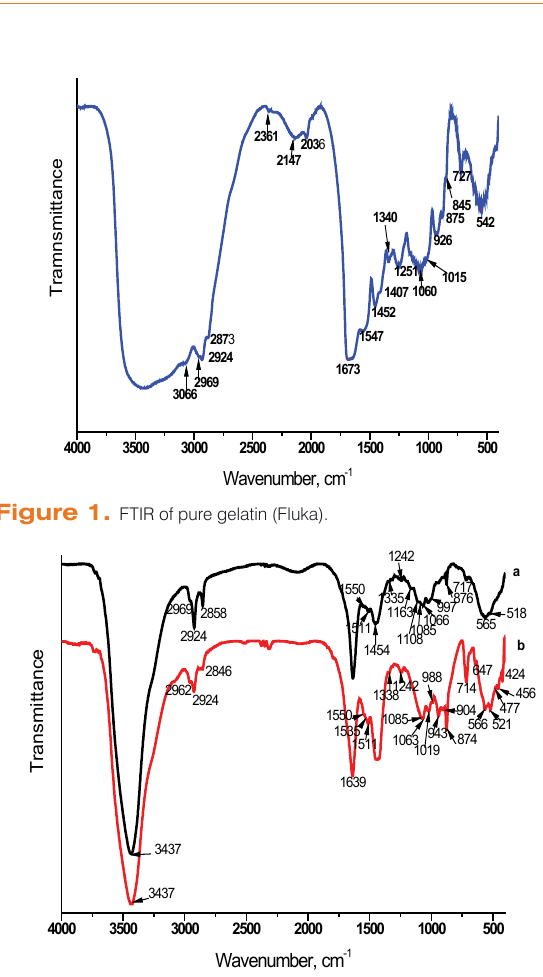
Figure 2. FTIR of the obtained G-CPS/W -75:25 wt. % (a) and 25:75 wt. % (b) before in vitro